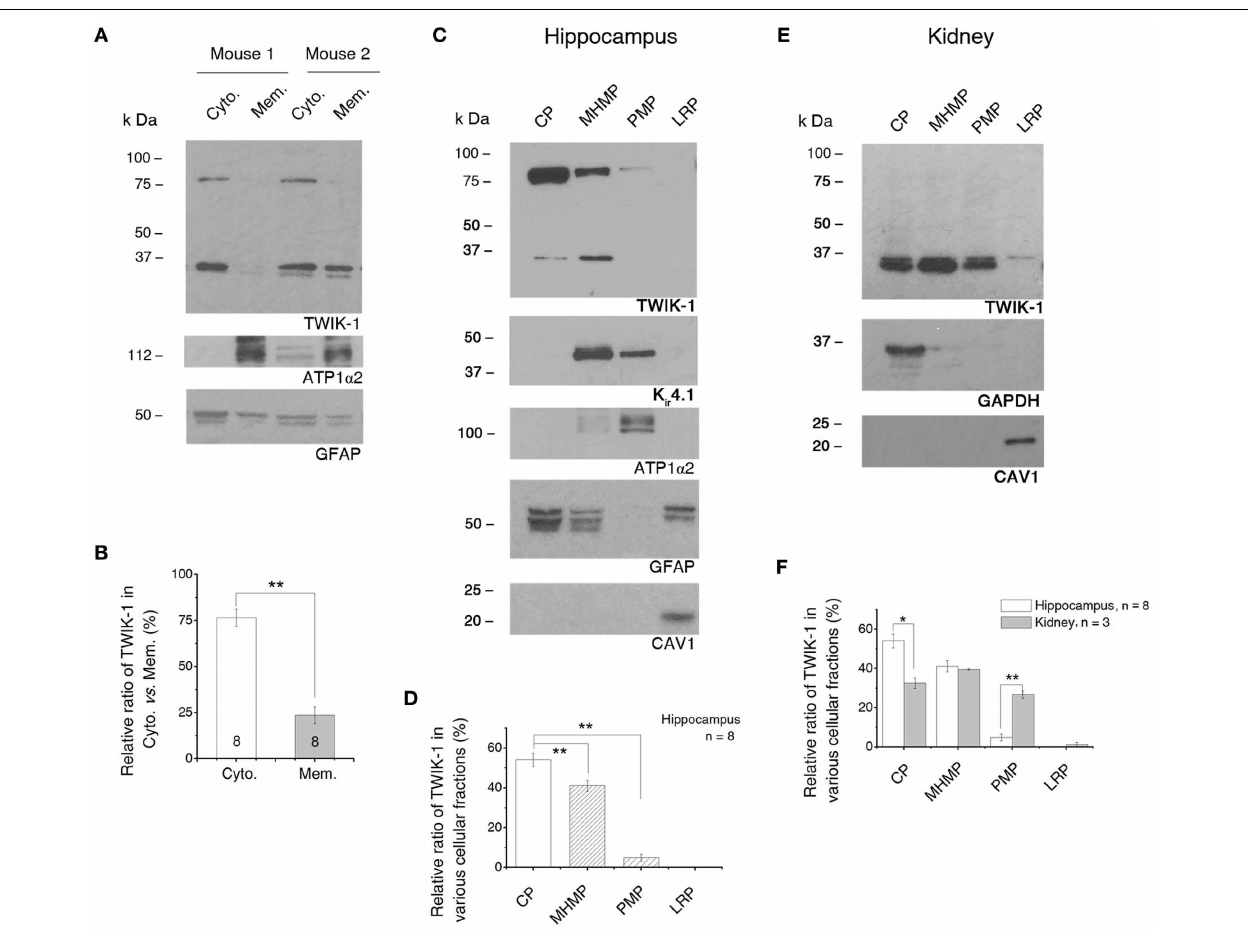
FIGURE 8 | TWIK-1 channels are predominantly located in cytoplasm. (A) Western blot results of TWIK-1 location in cytoplasmic vs . membrane proteins of two mice hippocampus. GFAP (50kDa) and ATP1 α 2 (112kDa) were markers for cytoplasmic and membrane fractions, respectively. Note that TWIK-1 dimer and monomer were mainly located in cytoplasmic fraction in both mice. (B) A bar graph showing the relative ratio of TWIK-1 proteins located in cytoplasmic and membrane fractions. (C) A representative blotting result from the second fractionation method (see Methods). Total protein from hippocampus was fractionated into cytoplasmic proteins (CP), mildly hydrophobic membrane proteins (MHMP), plasma membrane protein (PMP) and lipid raft proteins (LRP). GFAP, ATP1 α 2 and CAV1 (21kDa) were markers for CP, PMP and LRP, respectively. TWIK-1 also expressed highly in cytoplasm,